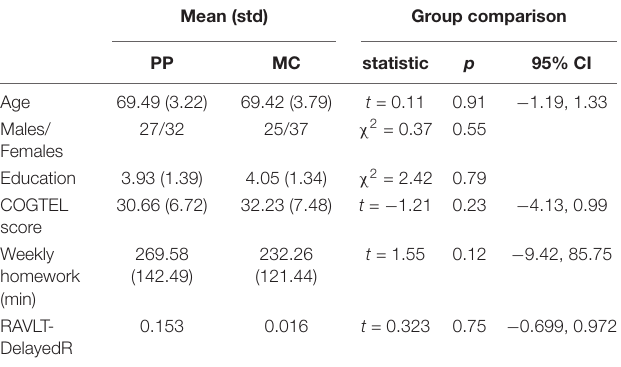
TABLE 1 | Demographic data and group comparisons ( N = 121).